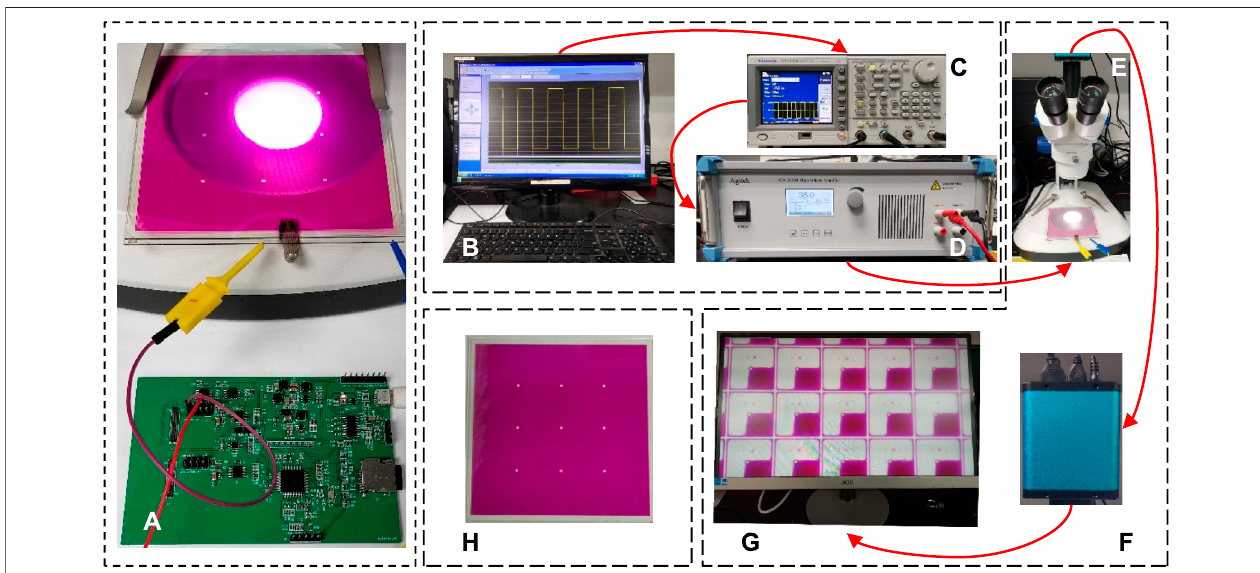
FIGURE 11 | Experimental platform of the driving waveform for EWDs. (A) A multi waveform driving system. (B) A computer. (C) An arbitrary function generator ATA-2022H (Agitek, Xi ’ an, China). (D) An AFG-3052C (Agitek, Xi ’ an, China) high voltage ampli fi er. (E) A Microscope. (F) A high-speed camera. (G) A PC for measuring system. (H) An EWD panel.